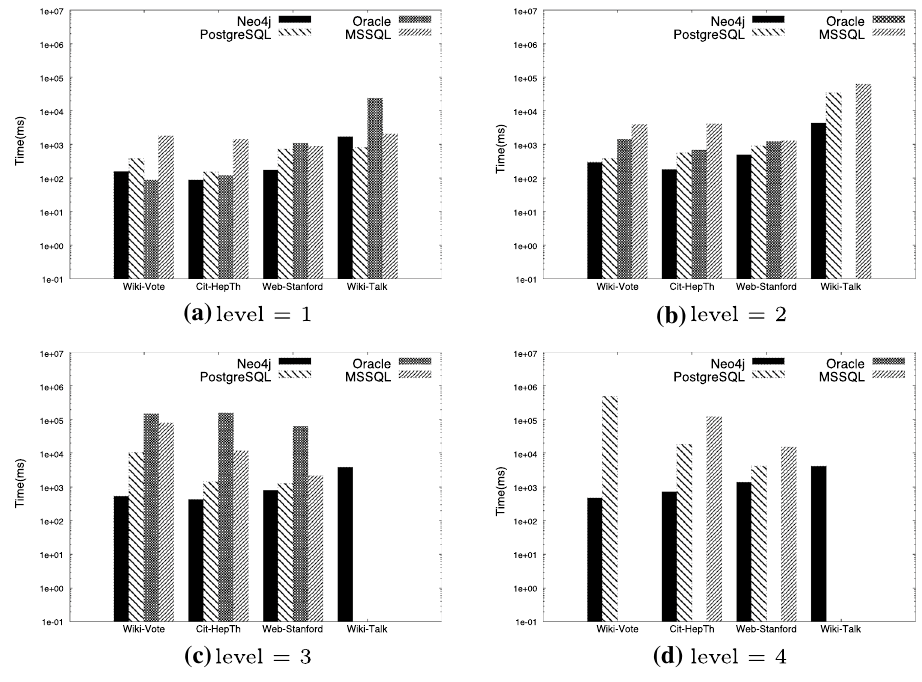
Fig. 10 Testing BFS algorithm over 4